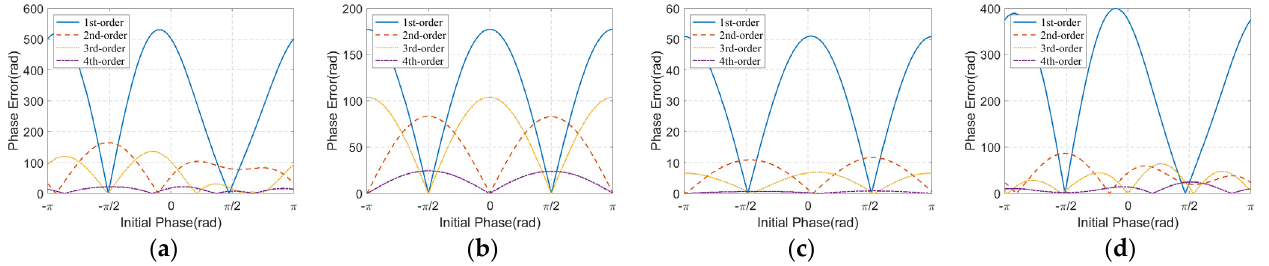
Figure 12. The maximum variation of each order phase error components introduced by destroyer angular oscillation. ( a ) Roll motion; ( b ) pitch motion; ( c ) yaw motion; ( d ) all the three angular oscillations.